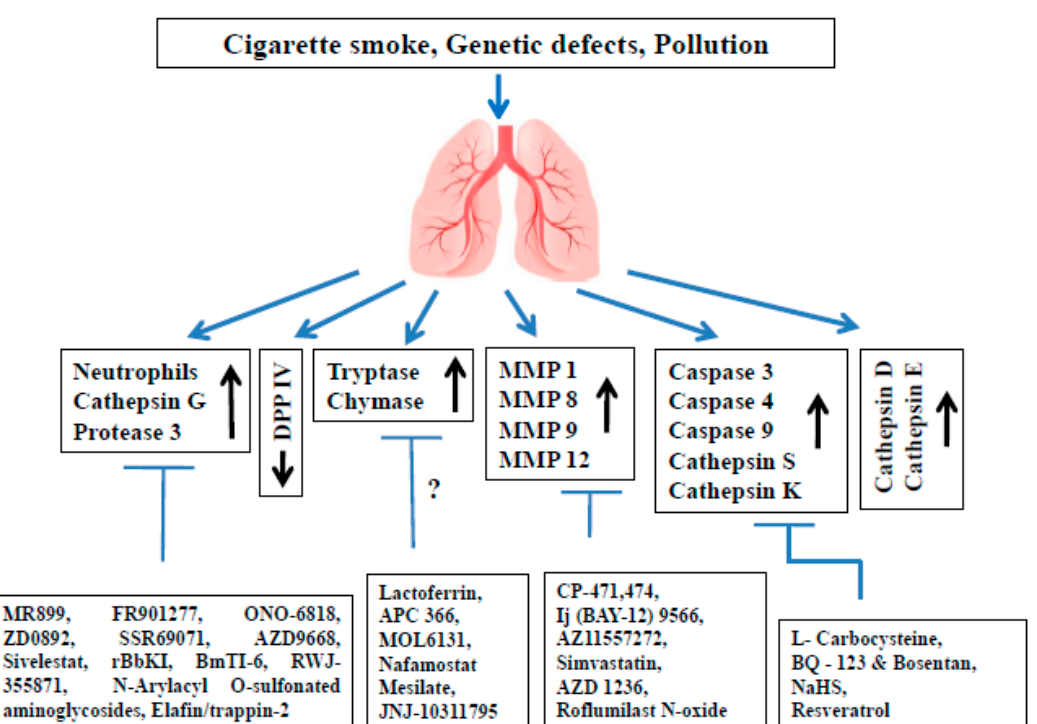
Figure 1. Present status of different protease inhibitors tested against COPD models. COPD: Chronic obstructive pulmonary disease; DPP IV: Dipeptidyl peptidase IV; MMP: Matrix metalloproteinase.